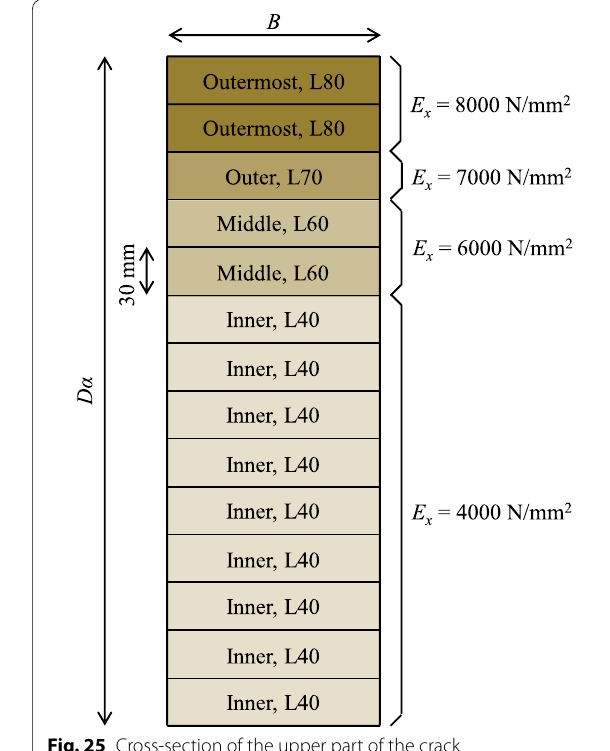
Fig. 25 Cross-section of the upper part of the